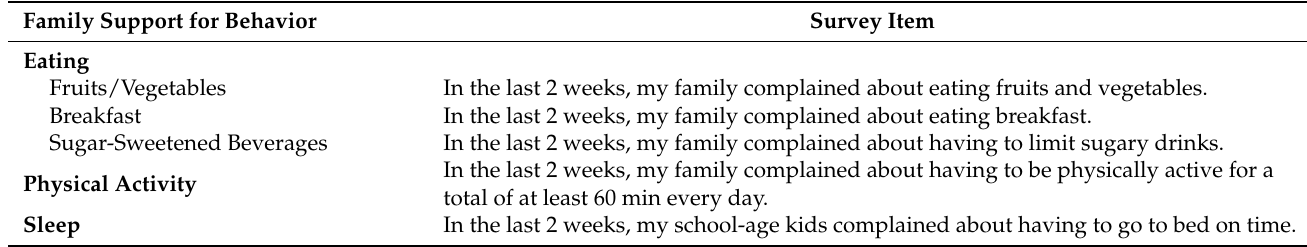
Table 1. Family Social Support for Healthy Behaviors Scale 1